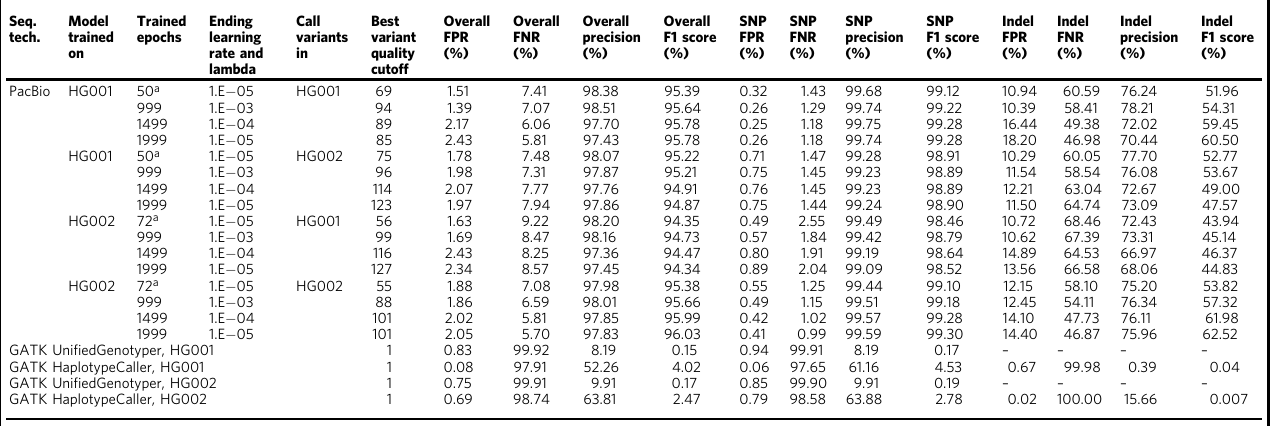
Table 4 Performance of Clairvoyante on ONT data at common variant sites in 1KGp3 Seq. Model Trained Tech. trained epochs on ONT HG001 110 (except for chr1)